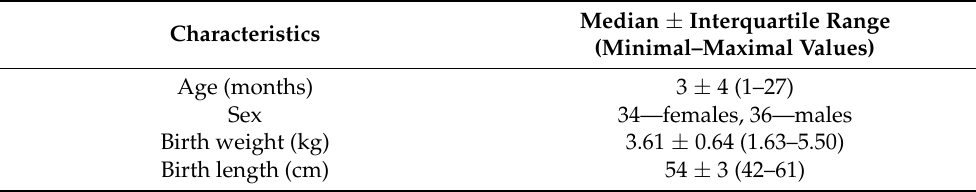
Table 2. Child’s